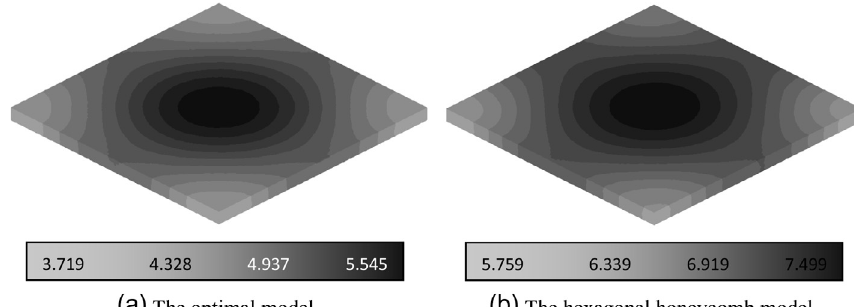
Figure 14. The deformation of the ceramic shell under pressure load